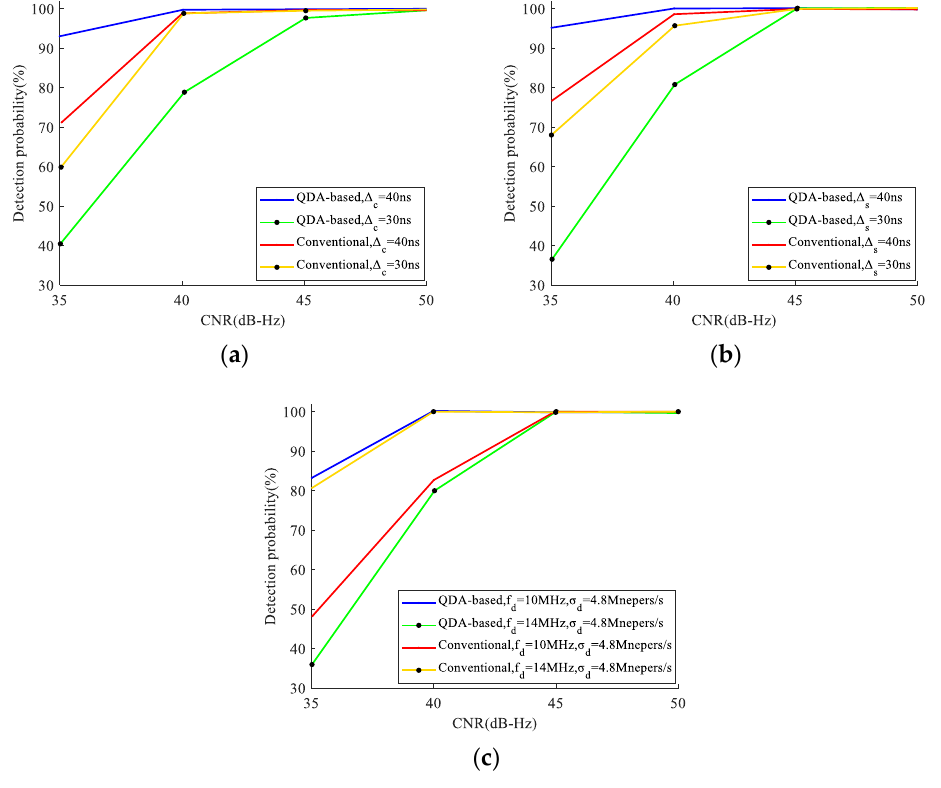
Figure 10. The algorithm in this paper is compared with the traditional method. ( a ) PN code distortions; ( b ) Subcarrier distortions; ( c ) Analog distortions.